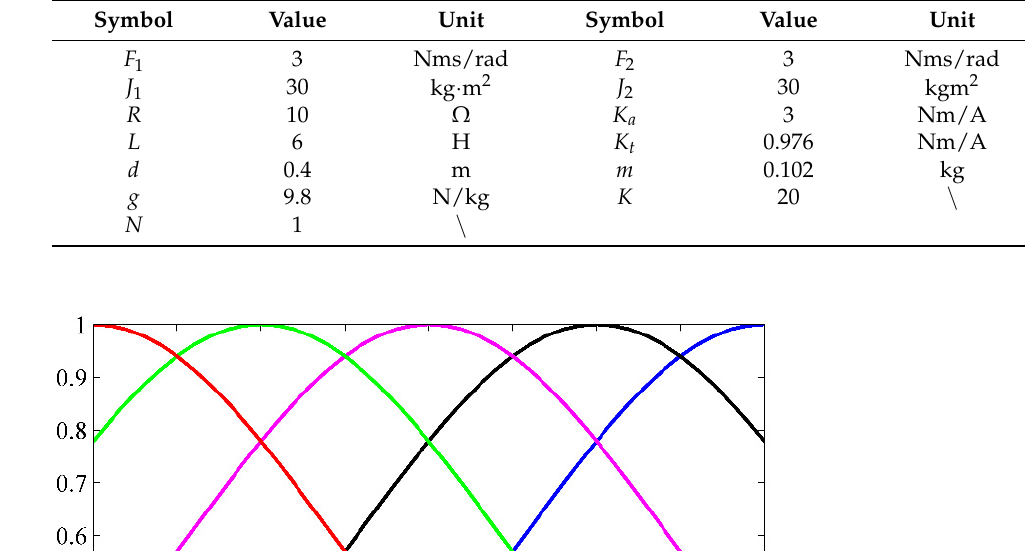
Table 1. The parameters of flexible robotic manipulator.